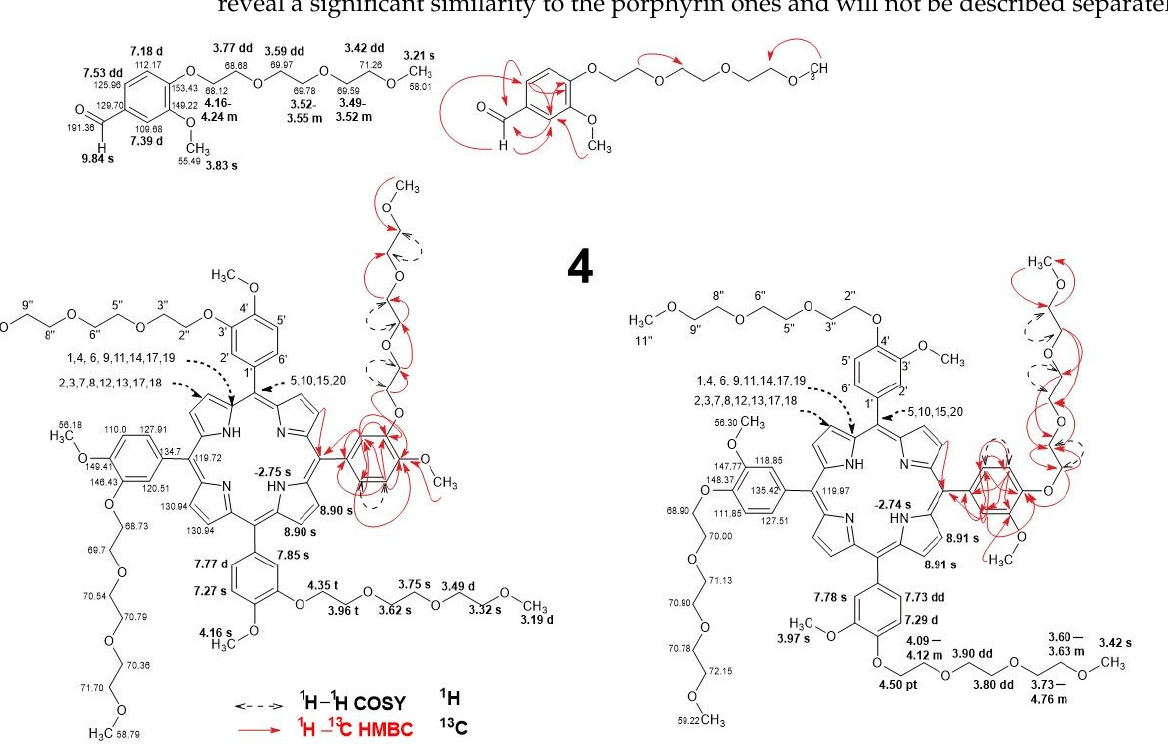
Figure 3. NMR data of aldehyde 1 and porphyrins 3 and 4 . Values in bold are for 1 H NMR while the normal text assigned to 13 C NMR. Chemical shifts are expressed as (ppm) in DMSO-d6 and CDCl 3 . Key HMBC and 1 H– 1 H COSY correlations are marked with dashed arrows and bold lines, respec- tively.